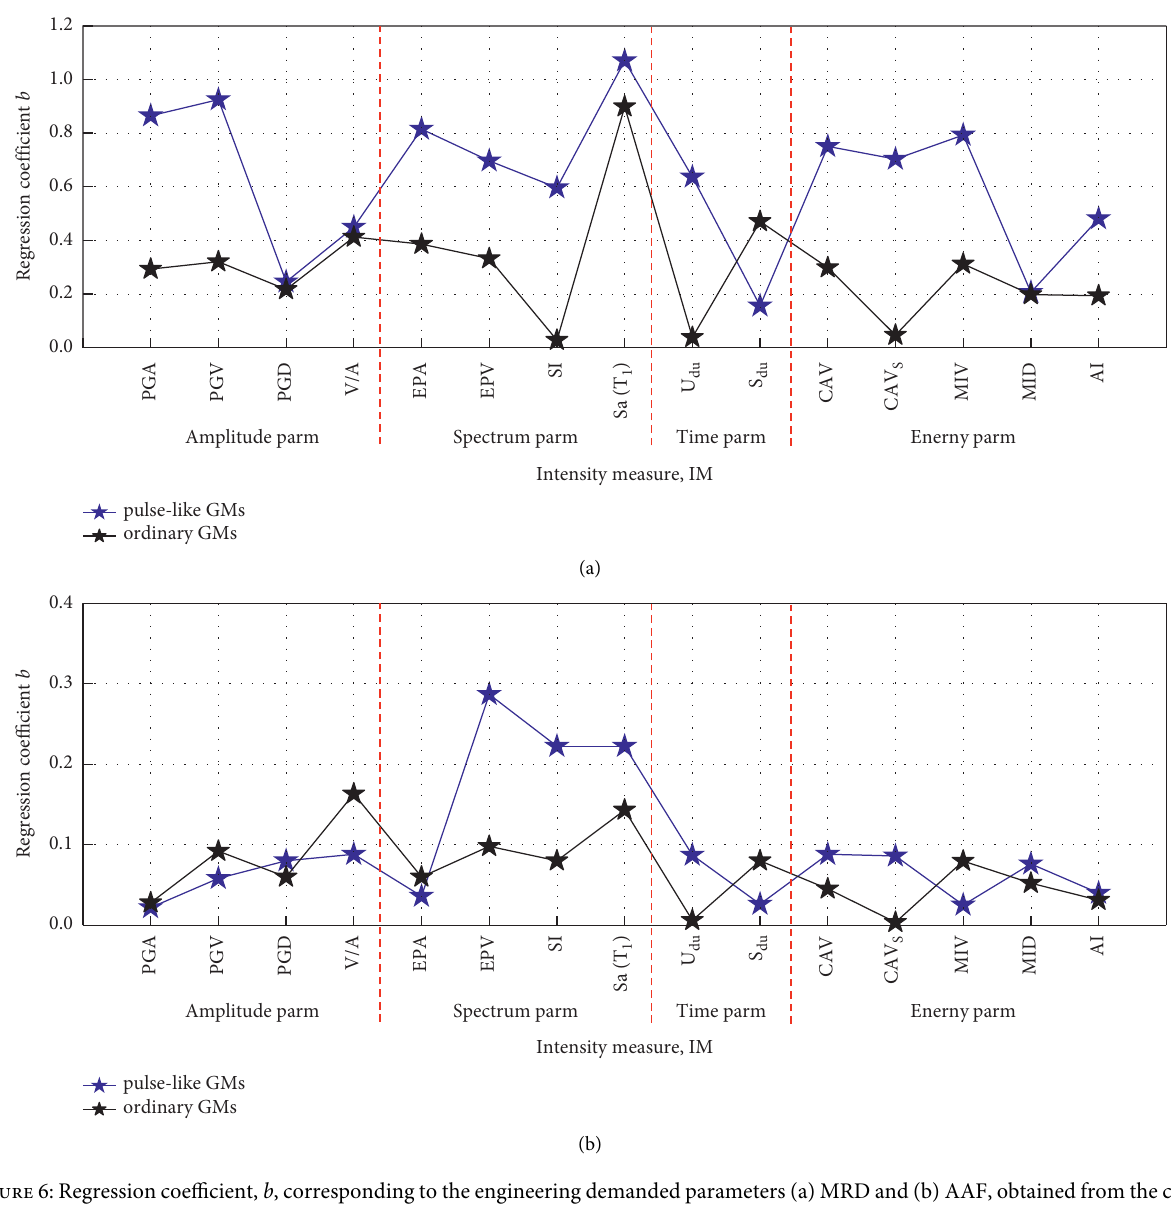
Figure 6: Regression coefficient, b , corresponding to the engineering demanded parameters (a) MRD and (b) AAF, obtained from the cloud analysis subjected to pulse-like and ordinary ground